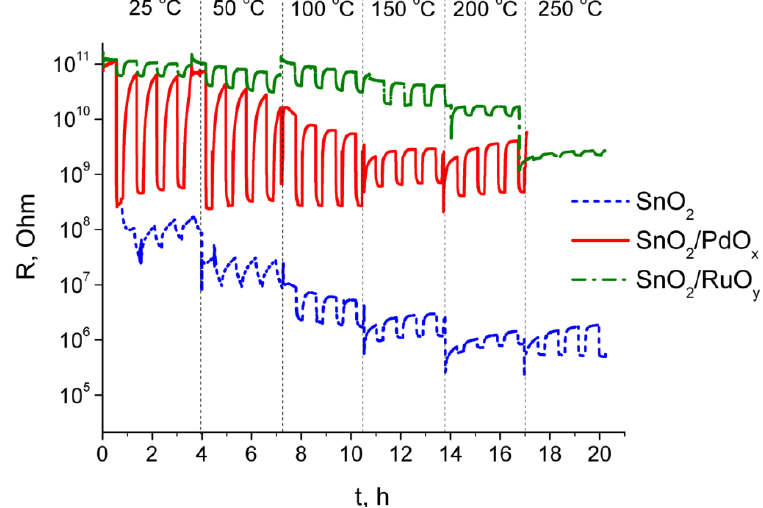
Figure 3. Dynamic resistance response of SnO 2 , SnO 2 /PdO x , and SnO 2 /RuO y sensors to the pulses of 50 ppm CO in air at different temperatures.